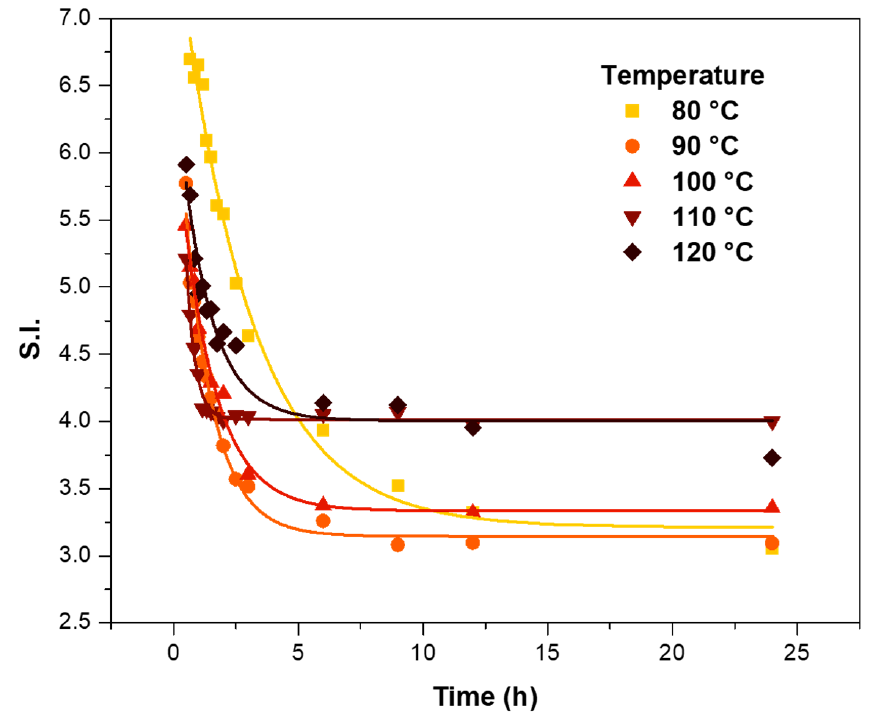
Figure 5. Temperature influence on swelling index results (A/CC = 1.1, t = 0–24 h). In Figure 5, it can be clearly seen that it is not efficient to raise the temperature to reduce curing times. Hence, 90 ◦ C can be a good choice because an earlier complete curing time (6 h) and appropriate final crosslinking degree are